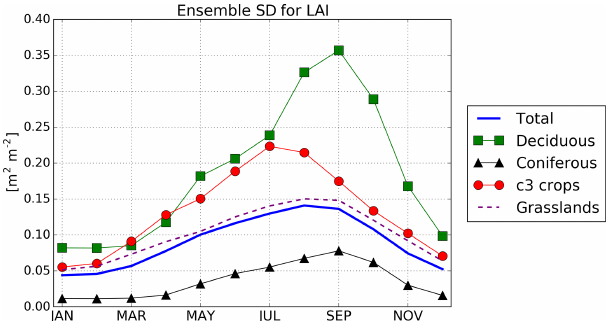
Figure 6. Seasonal standard deviation of the ensemble from the En- SRF averaged over the whole domain (thick blue line) and grid cells where deciduous broadleaved trees (green squares), coniferous trees (black triangles), C 3 crops (red circles) and grasslands (dashed pur- ple line) represent the majority of plants for the period